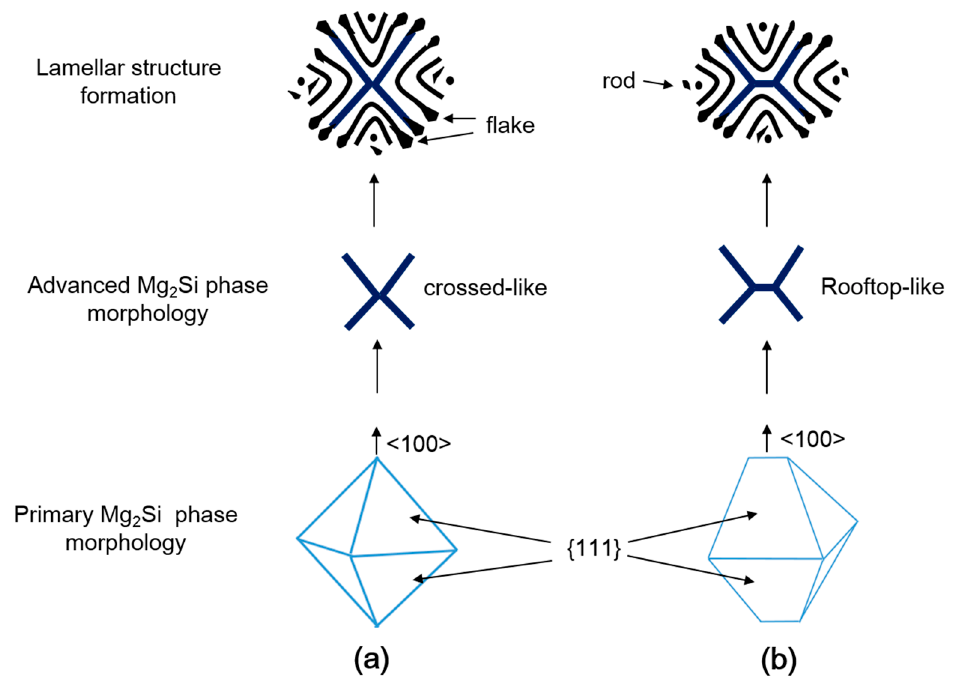
Figure 5. Schematic drawing to explain the mechanisms of evolution of eutectic phases from polygonal primary Mg2Si phases. ( a ) The formation of crossed-like advanced Mg2Si phase and subsequent lamellar structure formation upon it and ( b ) the evolution of lamellar structure from rooftop-like morphology of advanced Mg2Si phase (octahedral shapes are redrawn from ref. [15]).